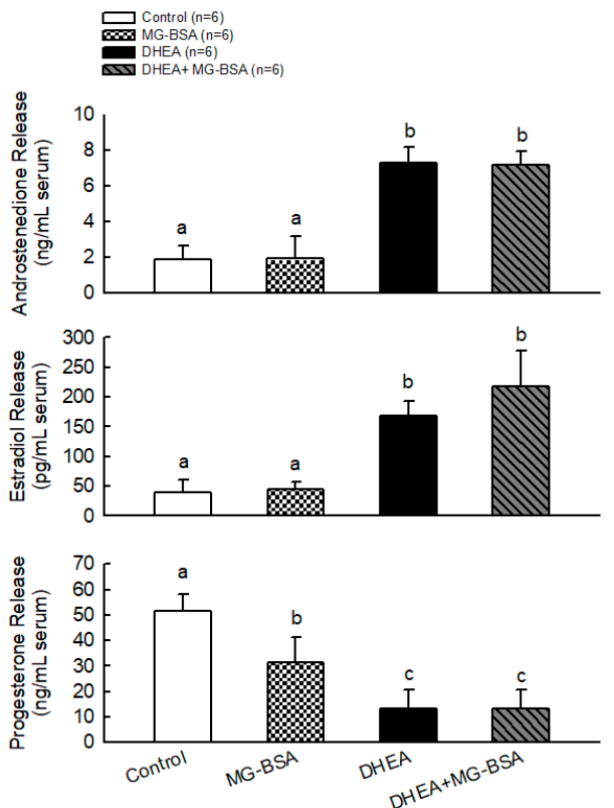
Figure 6. Effects of MG-BSA on serum hormone (androstendione, E2, and P4) levels of DHEA-induced PCOS rats. After sacrifice, blood was collected and serum was isolated. The serum levels of ( A ) androstendione, ( B ) estradiol, and ( C ) progesterone were measured using ELISA. Data are represented as mean ± SD ( n = 8). Different letters indicate significant differences among all groups ( p < 0.05).